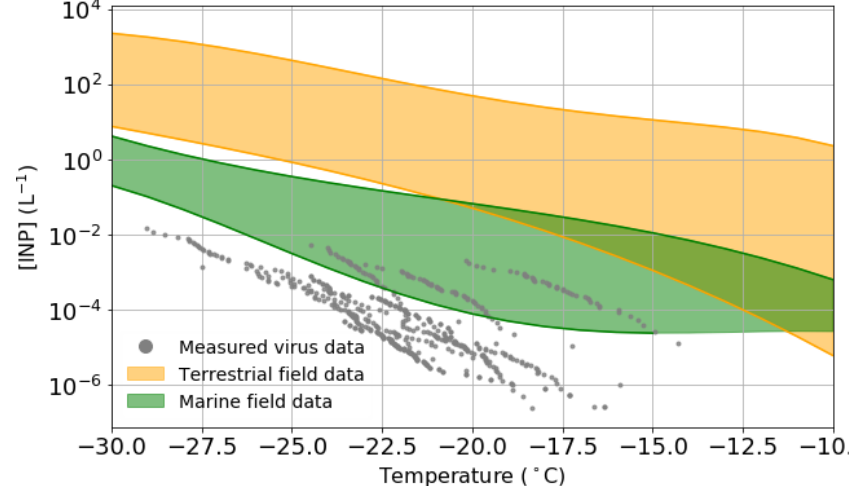
Figure 4. Estimated viral INP concentration based on measured ice-nucleating ability of virus particles and upper limit literature values of viral particle concentrations in the atmosphere compared to measured INP concentrations in both terrestrial (orange) and marine/polar (green) environments. Table S4 shows a list of the studies from which the data to create the field measurement envelopes were obtained. Temperature values have been corrected for freezing point depression of